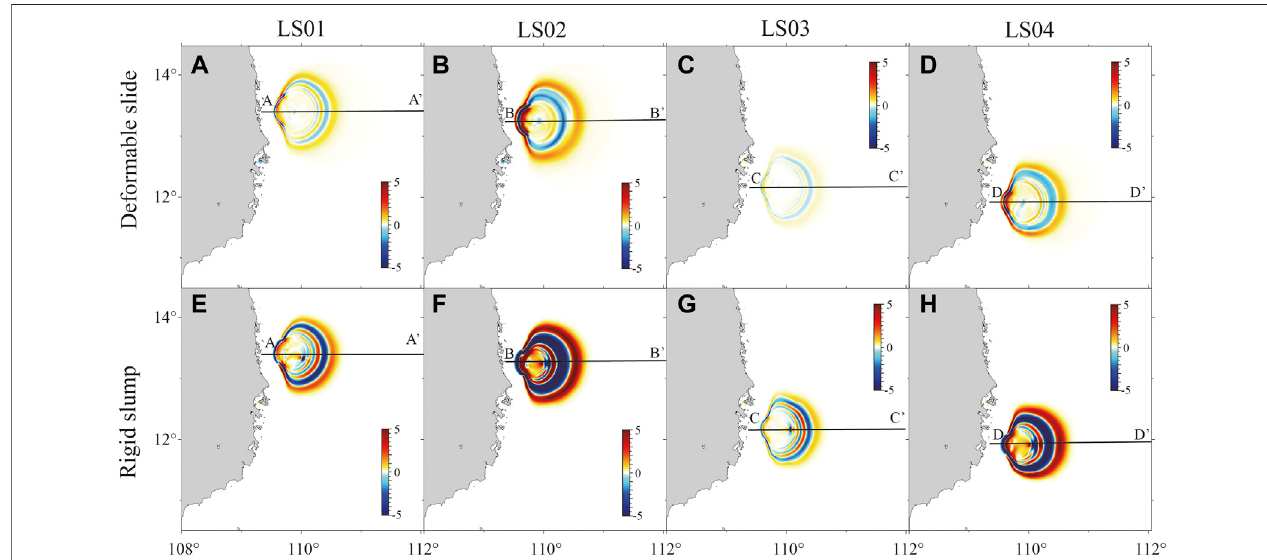
FIGURE 3 | Spatial distributions of the tsunami surface elevation at t = 10 min (A – D) : deformable slide of LS01-LS04; (E – H) : rigid slump of LS01-LS04.